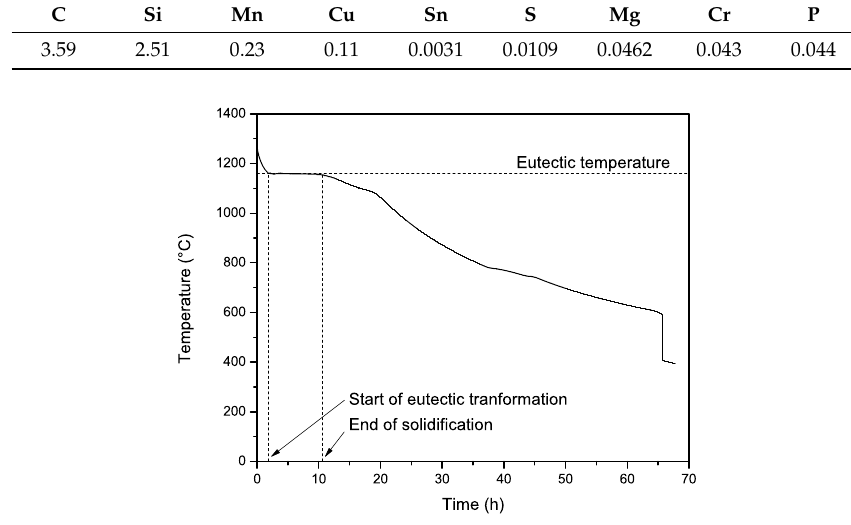
Figure 1. Record of the temperature measured by a thermocouple inserted into the casting during the solidification phase.